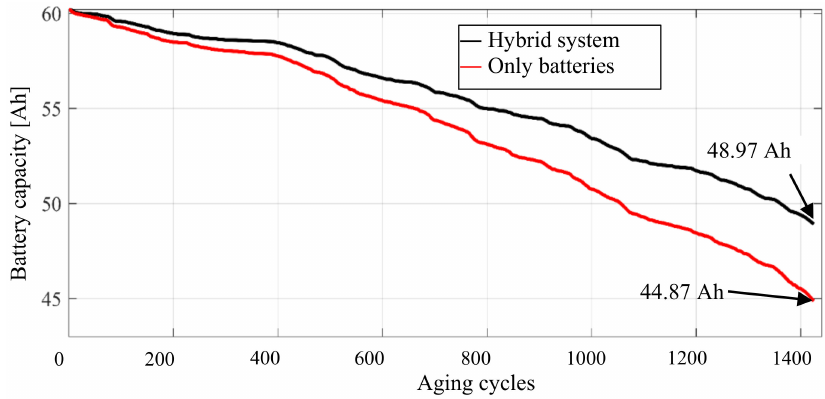
Figure 15. Comparison between the battery residual capacity after 1424 aging cycles for the two systems.